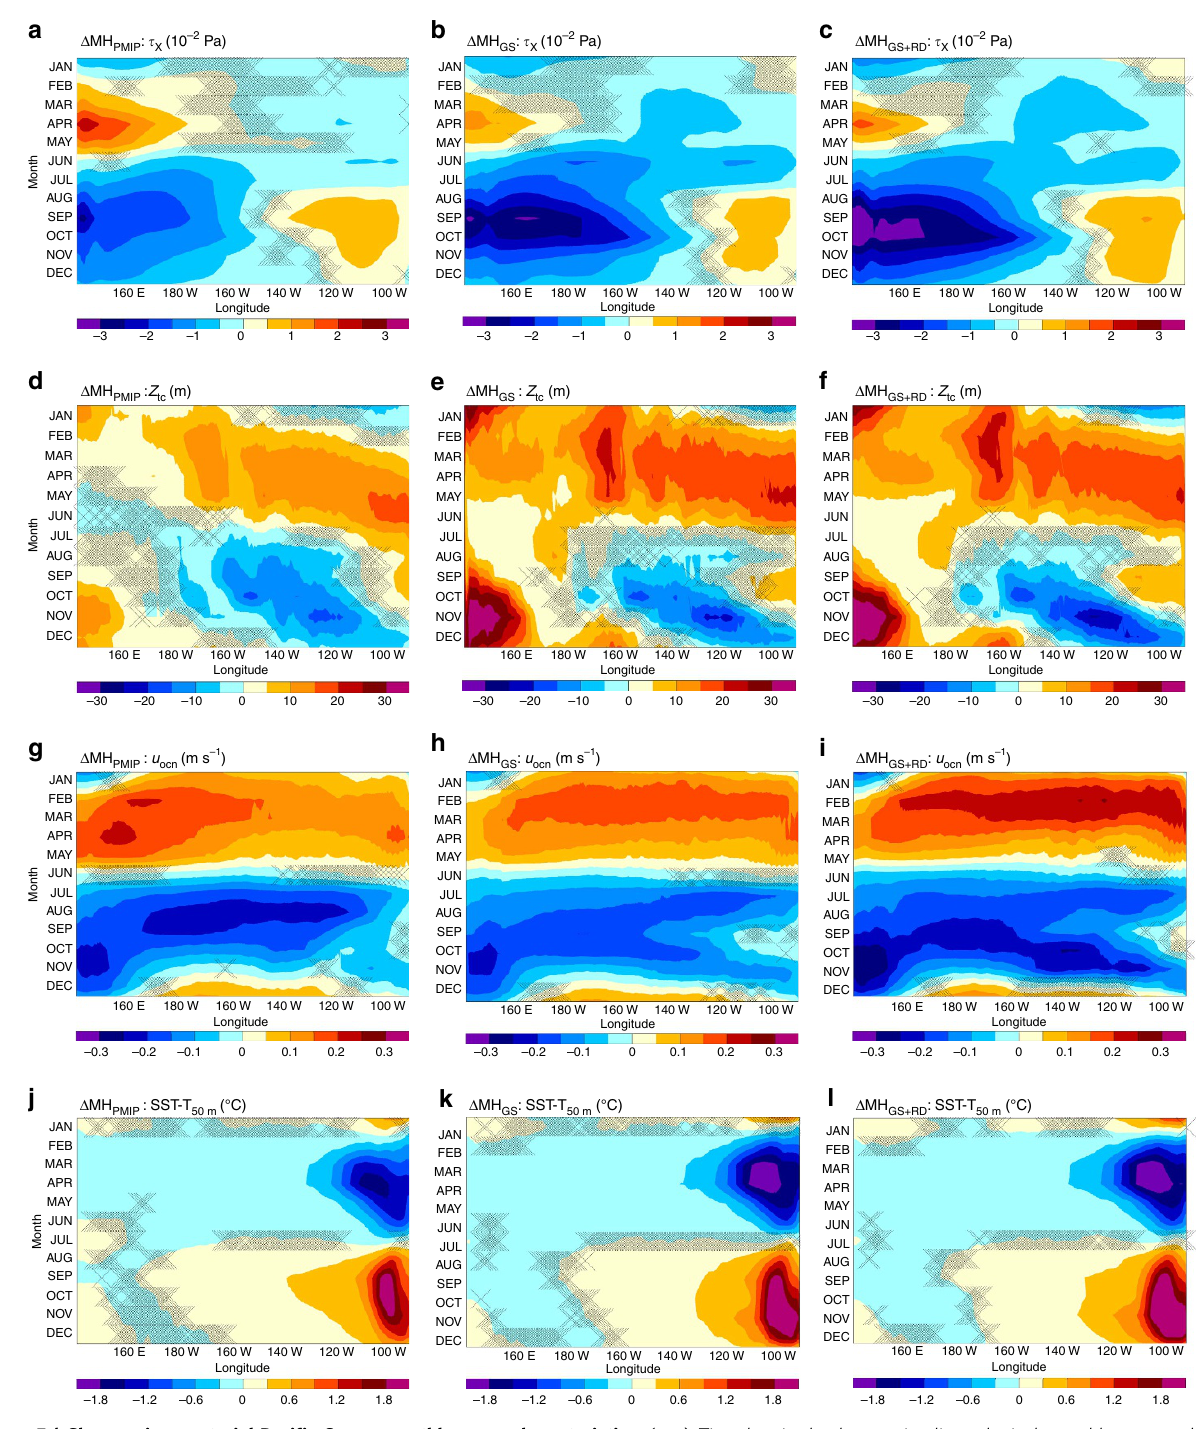
Figure 5 | Changes in equatorial Pacific Ocean monthly mean characteristics. ( a – c ) Time-longitude changes in climatological monthly eastward wind stress, ( d – f ) thermocline depth as captured by the 20 (cid:2) C isotherm, ( g – i ) surface ocean current velocity, and ( j – l ) temperature stratification (SST—Tat 50m depth) between PI and each MH experiment. All fields are averaged between 5 (cid:2) S and 5 (cid:2) N. The hatched areas indicate regions in which the changes are not significant at 95% confidence level assessed using a two-sided t